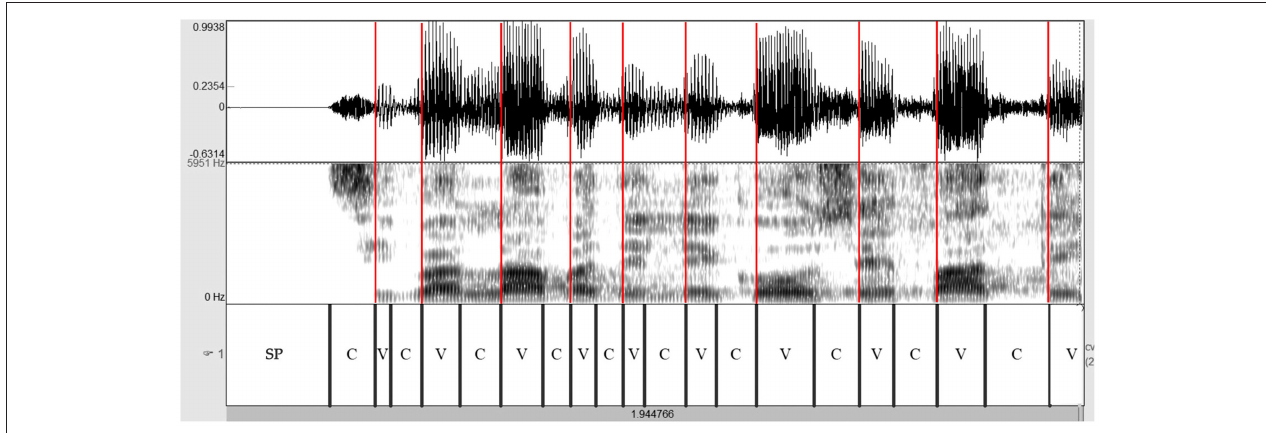
FIGURE 1 | Spectrogram of the utterance “ si parlava delle cose fatte ” (PD male voice—read speech). Red lines are placed in correspondence with the VOPs. Based on the spectrographic tracing and even more from the amplitude trend of the complex wave, it is clear that these instants coincide with the discontinuity points of the signal, on which the perception of rhythm is based. PD, Parkinson’s disease; C, consonantal interval; V, vocalic interval; SP, silent pause; VOPs, vowel onset points.